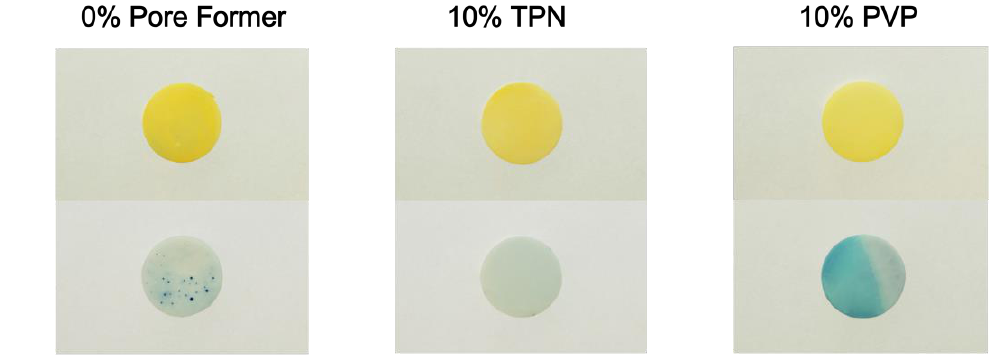
Figure 5. Photographs of EC, 10% TPN-EC, and 10% PVP-EC matrix films after incubation in pH 1.2 media for 2 h and then pH 6.8 for an additional 22 h containing bromocresol green.